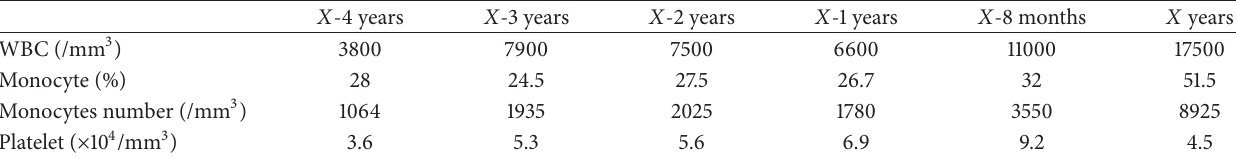
Table 2: The number of PB-monocytes and platelets during 4 years.